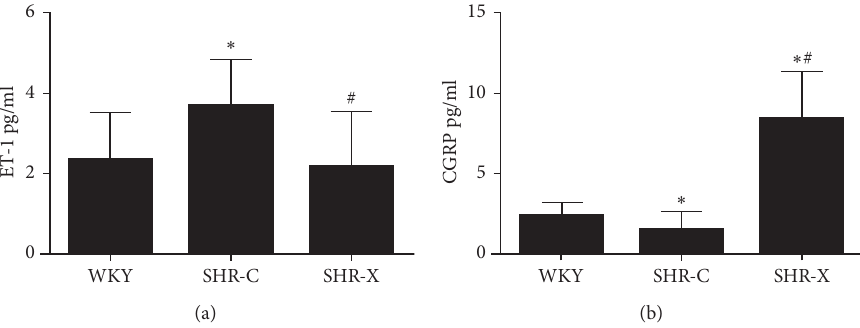
Figure 2: The effect of Xinmaitong on the blood vasoactive materials ET-1 and CGRP. Values are means ± SD. WKY: Wistar-Kyoto rats; SHR: spontaneously hypertensive rats; SHR-C: SHR control; SHR-X: SHR Xinmaitong treatment; ET-1: endothelin-1; CGRP: calcitonin gene-related peptide. ∗ P < 0 . 05 versus WKY. # P < 0 . 05 versus